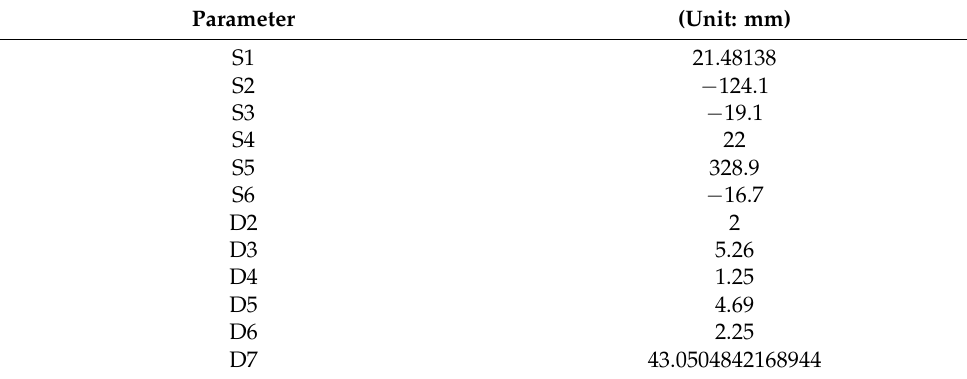
Table 2. Initial design parameters of Cooke triplet (Case 1).